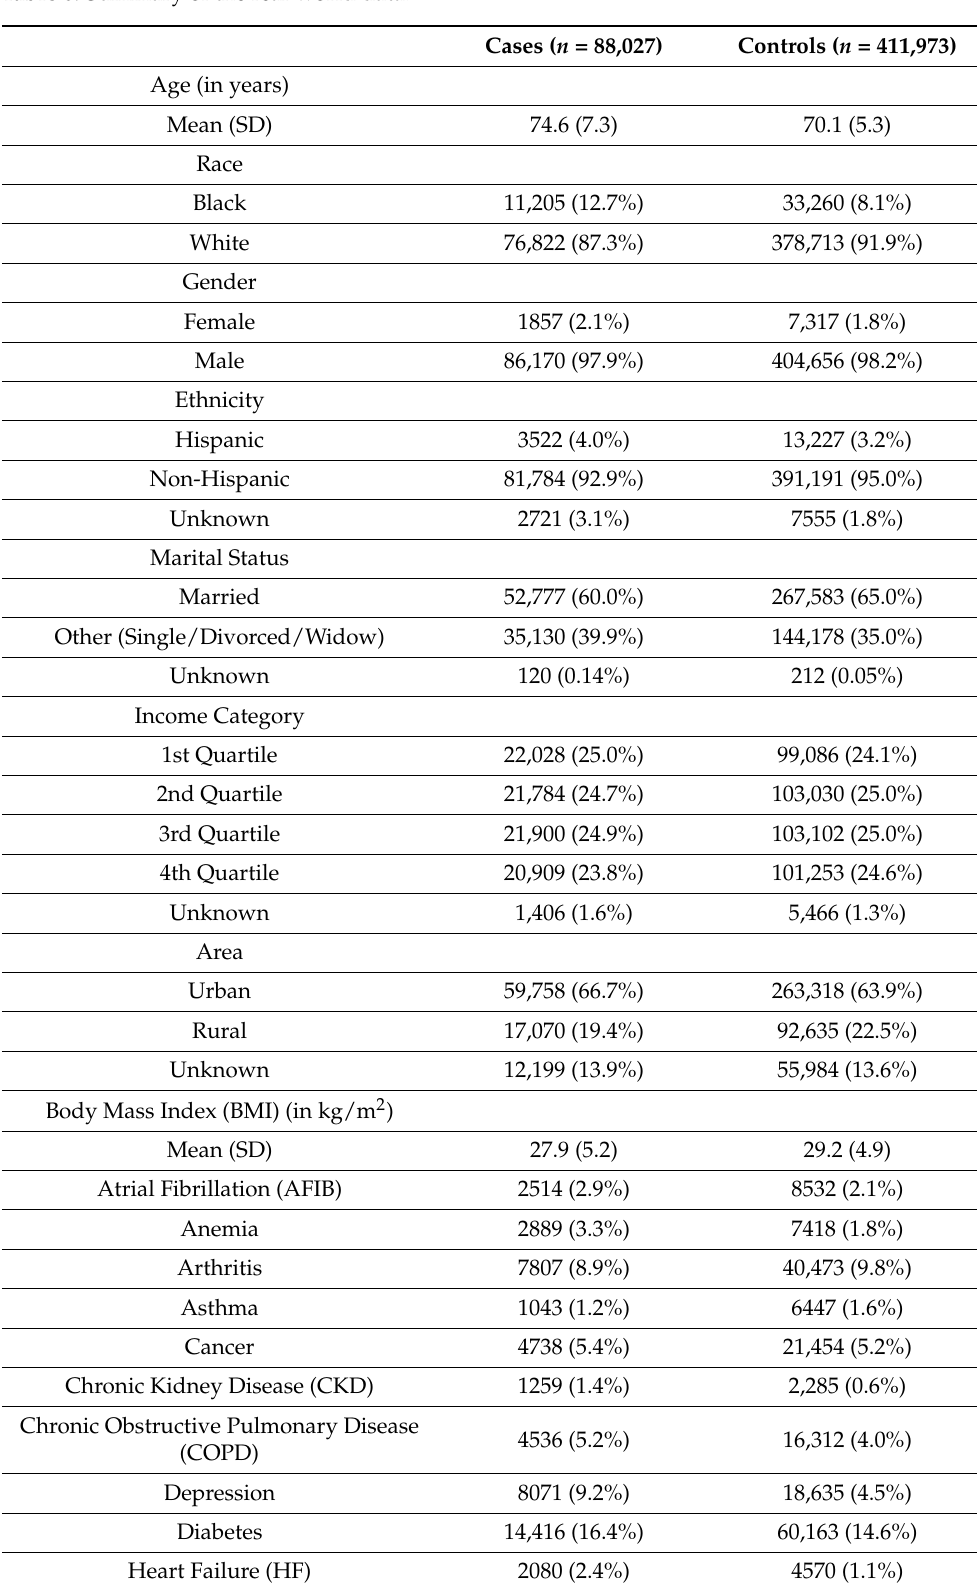
Table 6. Summary of the real-world